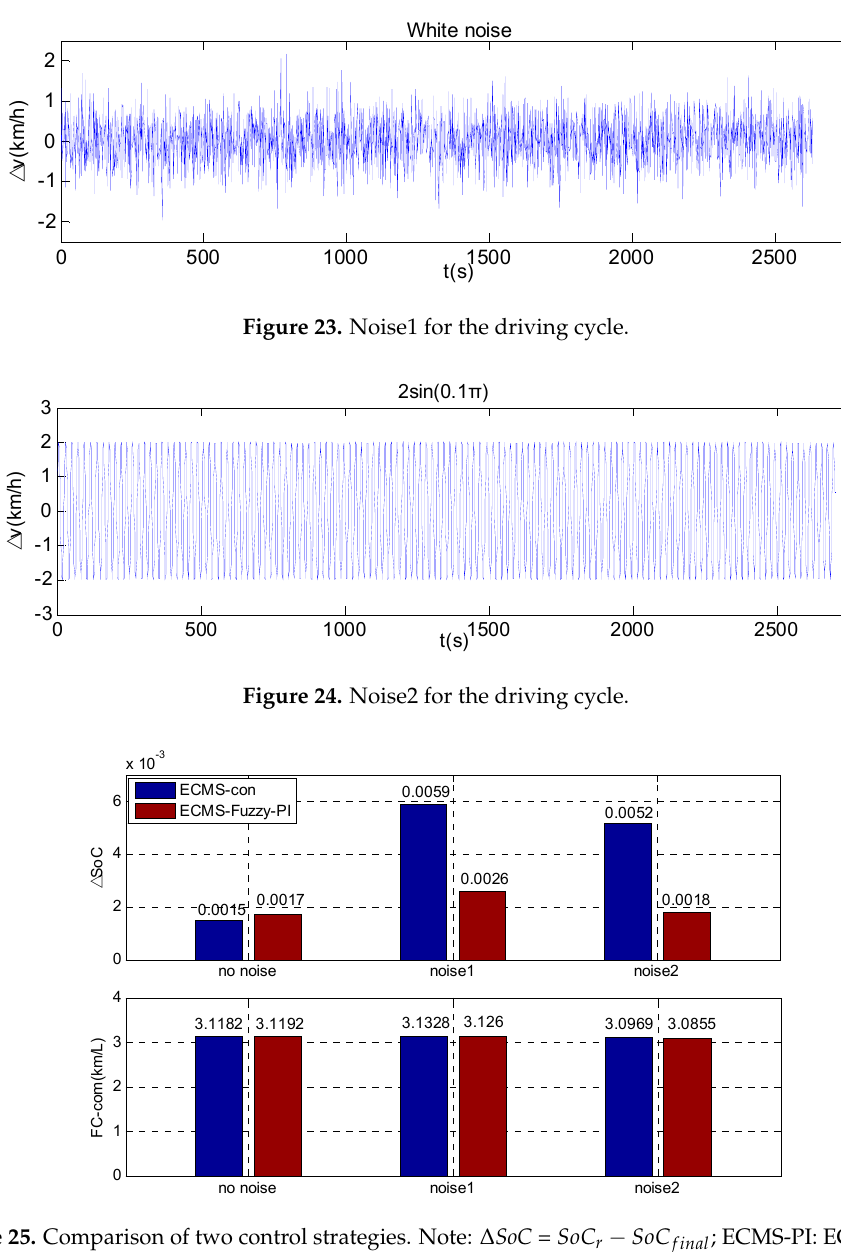
22 of 26 Figure 22. Distribution of the motor operating point (Rule-based). 5.4. Robustness to Driving Cycles To further evaluate the robustness of the proposed Fuzzy PI adaptation law, simulations are conducted using the optimal EF applied in ECMS by adding variation to the driving cycle. In this paper, two kinds of noise signal are considered, as shown in Figures 23 and 24. The comparison of fuel consumption along with final SoC over the 2 × CHA cycle is shown in Figure 25. We compare the performance of the approximate optimal EF applied in ECMS (ECMS-con) and the Fuzzy-PI adaptation law in ECMS (ECMS-Fuzzy-PI). As shown in Figure 25, the deviation between the final SoC and the reference value is almost the same when no noise signal is added to the driving cycle, reaching 0.0015 and 0.0017 for ECMS-con and ECMS-Fuzzy-PI, respectively. Both ECMS-con and ECMS can achieve better performance in